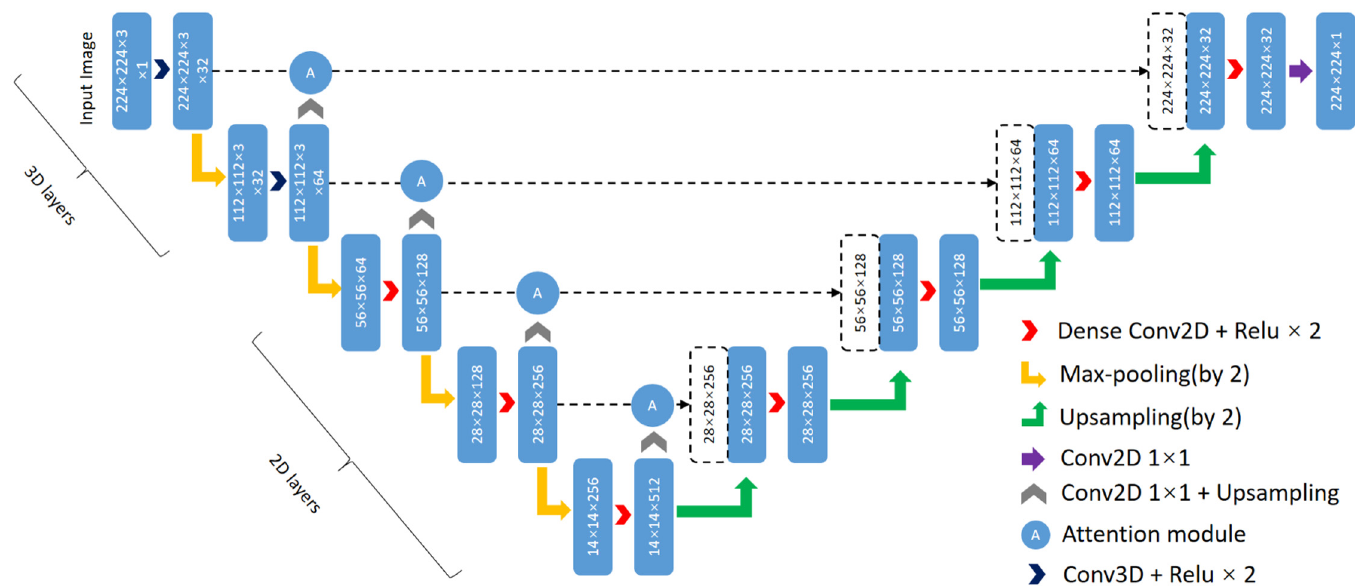
Fig 4. Illustration of the proposed multi-scale attention net. Dense block is show in Fig 5 and the proposed attention module is shown in Fig